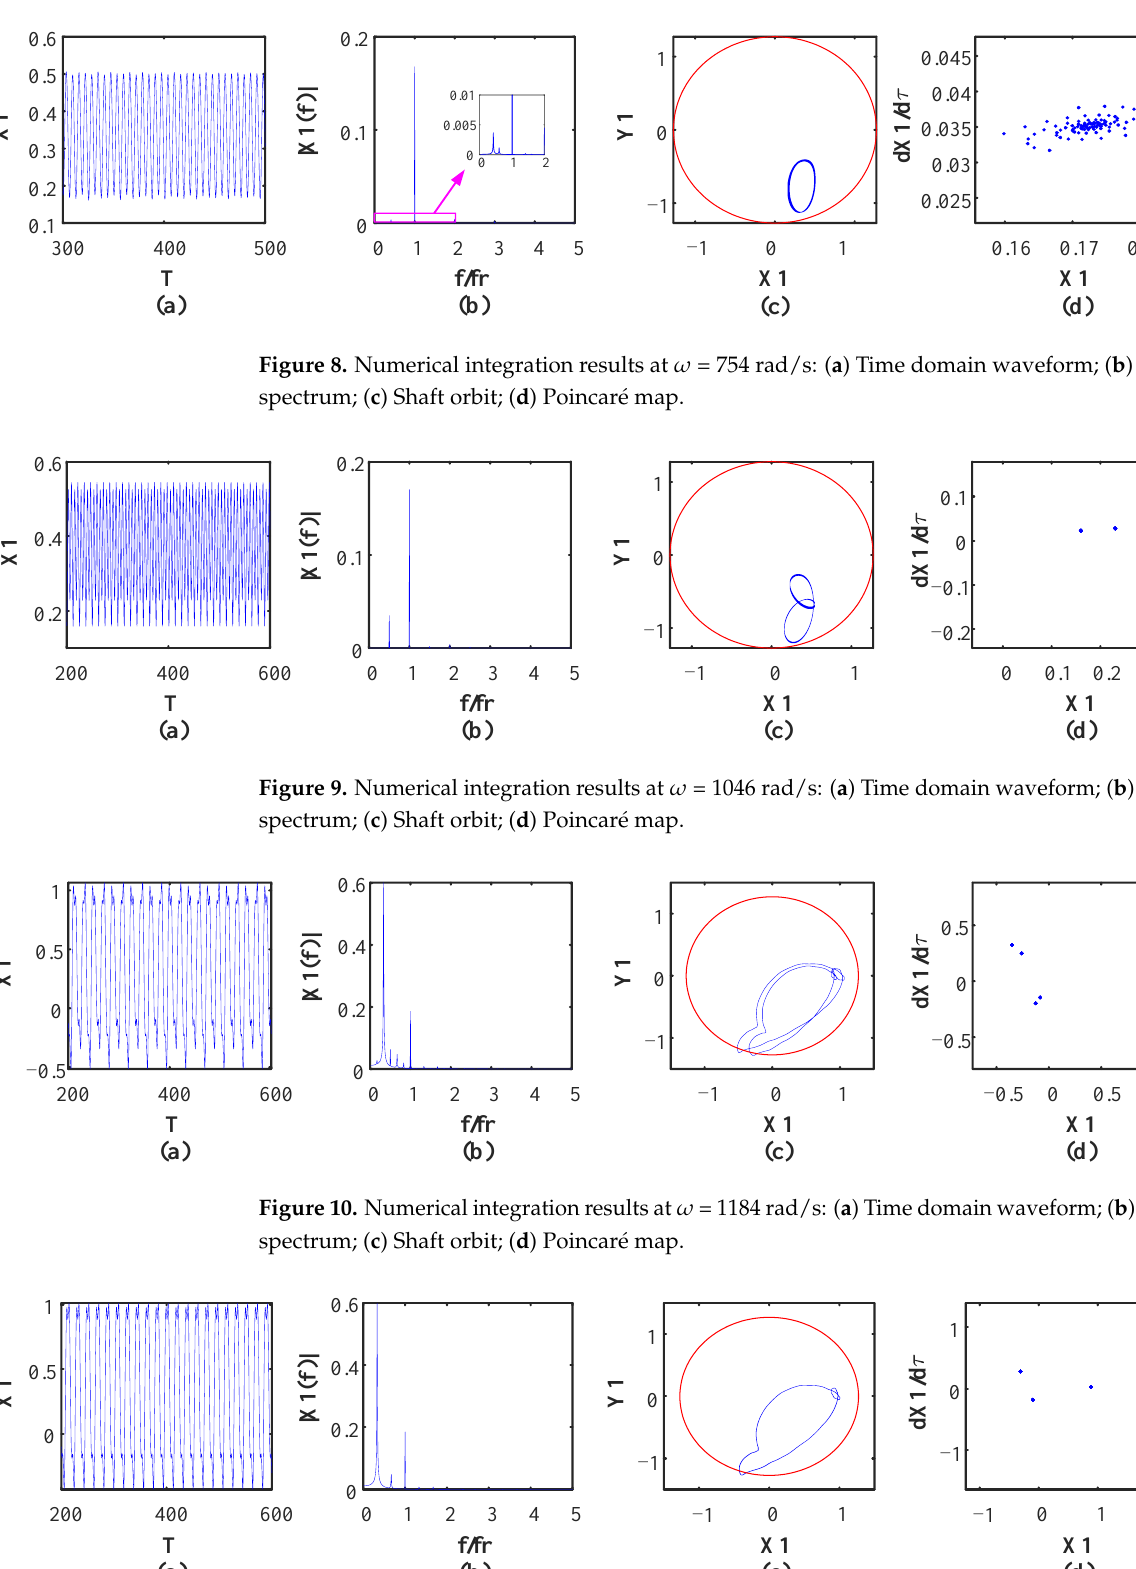
Figure 7. Numerical integration results at ω = 680 rad/s: ( a ) Time domain waveform; ( b ) Frequency spectrum; ( c ) Shaft orbit; ( d ) Poincaré map.